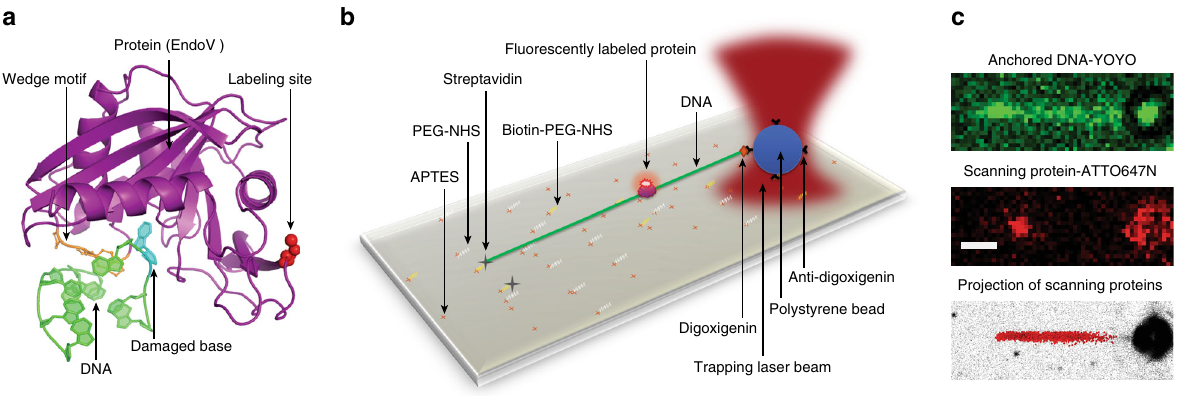
Fig. 1 Protein – DNA interaction experiment. a Crystal structure of Thermotoga maritima (Tma) EndoV (purple) in complex with deaminated DNA (green). The protein labeling site (red spheres) does not interfere with DNA binding and damage recognition (cyan base in DNA). The PYIP-wedge motif (orange) consists of the four residues: Pro79, Tyr80, Ile81 and Pro82. b Single-molecule experimental setup. APTES (3-Aminopropyl)triethoxysilane, PEG-NHS N - hydroxylsuccinimide (NHS) functionalized polyethylene glycol, Biotin-PEG-NHS biotinylated PEG-NHS. The position of the polystyrene bead is controlled by a steerable optical trap, and used to linearize the DNA. c Upper panel: epi fl uorescence microscopy image of linearized DNA labeled with intercalating dye YOYO-1 (not present during the protein scanning experiments). Middle panel: a single fl uorescently labeled EndoV molecule interacting with linearized DNA. Lower panel: projection of all detected trajectories of one data set of EndoV along the DNA. White scale bar equals 1 µ